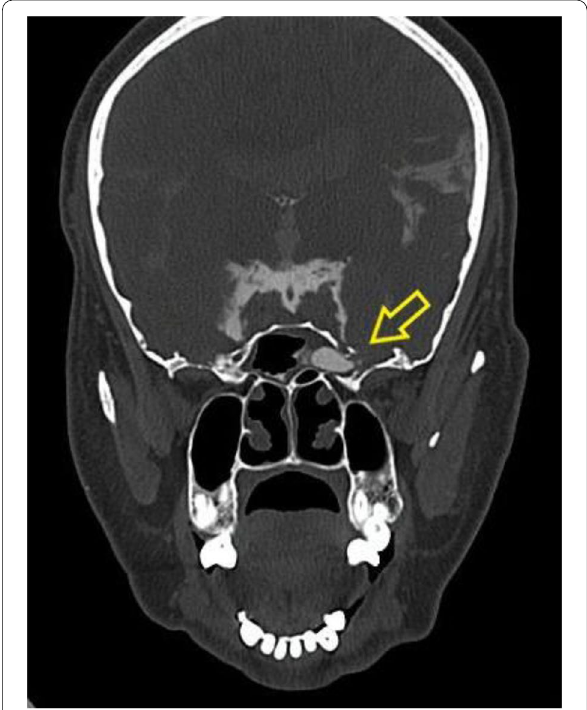
Fig. 1 The pre-operative CT cisternography of a patient with a left lateral recess of sphenoid sinus leak showing contrast flowing via the defect (arrow) into the left sphenoid